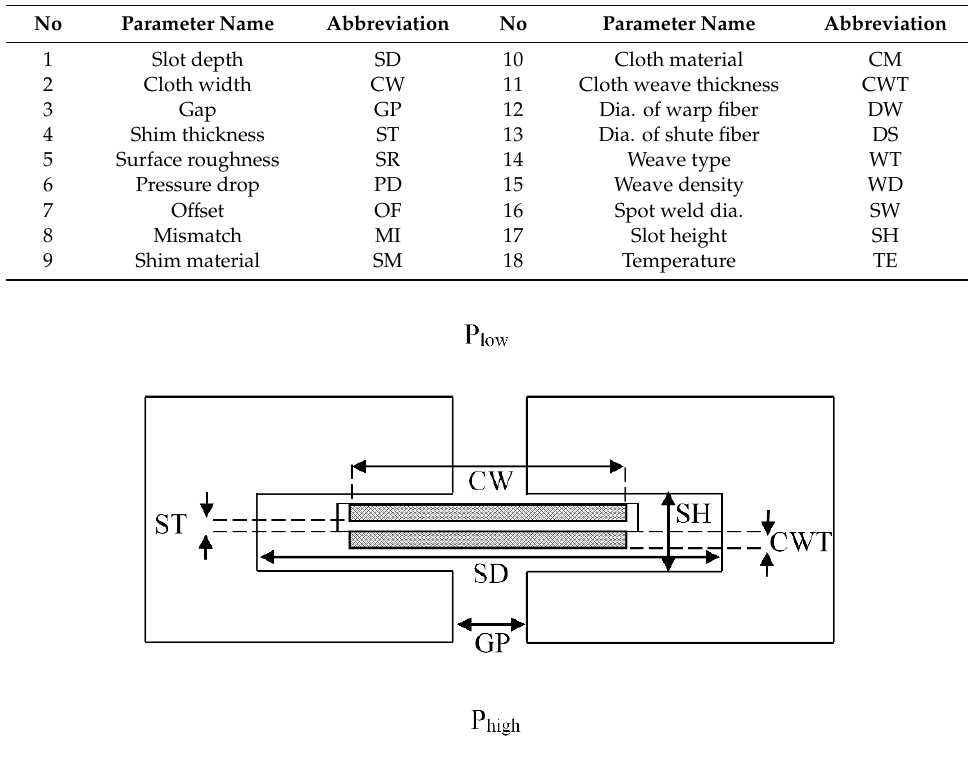
Figure 8. Cloth seal geometric parameters.